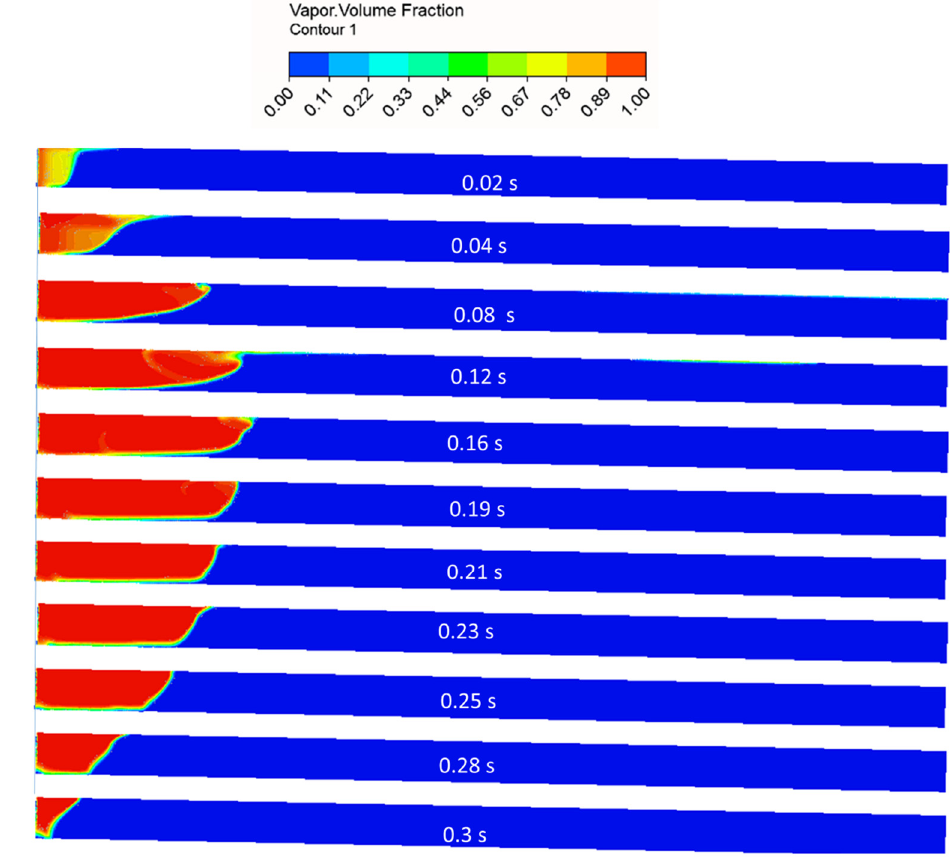
Figure 8. Pressure time histories calculated by 1D-3D at; ( a ) valve; ( b ) pipe mid-point.